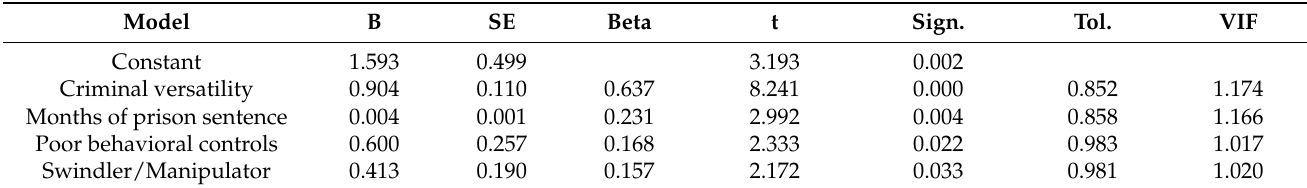
Table 3. Linear regression indices of the first model.